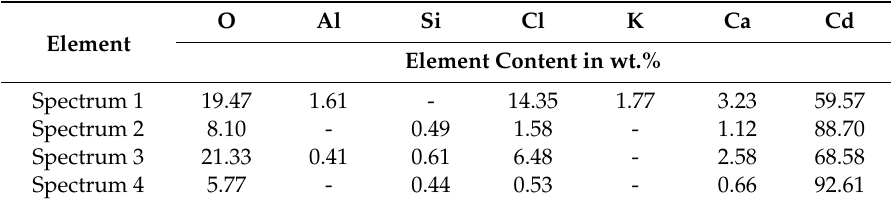
Figure 6. X-ray energy-dispersive spectrometer (EDX) spectrum of CD6-6 without preliminary surface cleaning—scanning areas 1–3 ( a ) and after surface cleaning—scanning area 4 (b ) and their spectra, ( c ) and ( d ), respectively. Table 2. Element composition in wt.% of sample CD6-6.